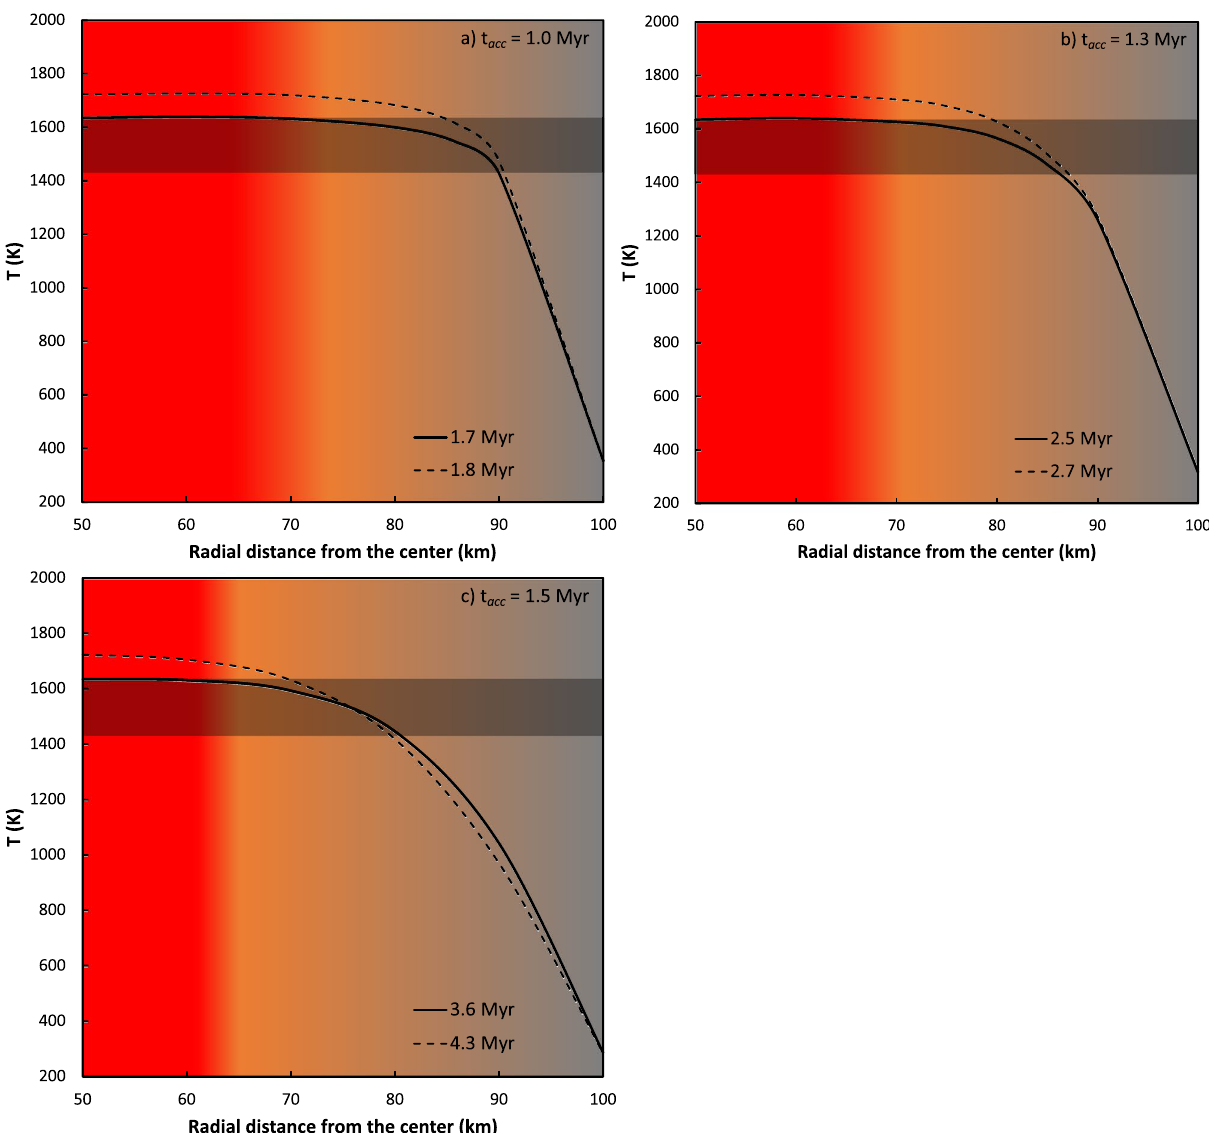
Figure 3. The calculated temperature (T in Kelvin) versus radial distance (r in km) from the center of the 200 km diameter aubrite parent body (AuPB) at 1 AU from the Sun at different times (shown by solid and dashed curves) assuming that the time of accretion was ( a ) 1.0 Myr; ( b ) 1.3 Myr; and ( c ) 1.5 Myr after CAI formation. The parameters used for these calculations are listed in Supplementary Table S3. Warmer colors represent higher temperatures with increasing depth from the surface of the AuPB. The black solid curve corresponds to the thermal profile with interior T of 1635 K (i.e., the highest estimated metal-silicate equilibration temperature recorded in the aubrite metals in this study). The black dashed curve represents the thermal gradient with interior T of 1723 K beyond which > 50% silicate melting would lead to obliteration of the thermal gradient in the AuPB (see text for details). Horizontal gray bar illustrates the range of metal-silicate equilibration temperatures (1432–1635 K) estimated for the aubrite metals in this study. The thermal gradient within the AuPB inferred from the metal-silicate equilibration temperatures recorded by the aubrite metals in this study is attained by ( a ) 1.7–1.8 Myr (for t acc = 1.0 Myr), ( b ) 2.5–2.7 Myr (for t acc = 1.3 Myr), and ( c ) 3.6–4.3 Myr (for t acc = 1.5 Myr) after CAI formation . Therefore, the aubrite parent body likely acquired this thermal gradient well within 4.3 Myr after CAI formation (assuming its accretion occurred within ~ 1.5 Myr after CAI formation 42 ). Note that the required minimum depth of excavation increases with increasing accretion time, with an excavation depth of at least ~ 35 km for an accretion time of ~ 1.5 Myr after CAI